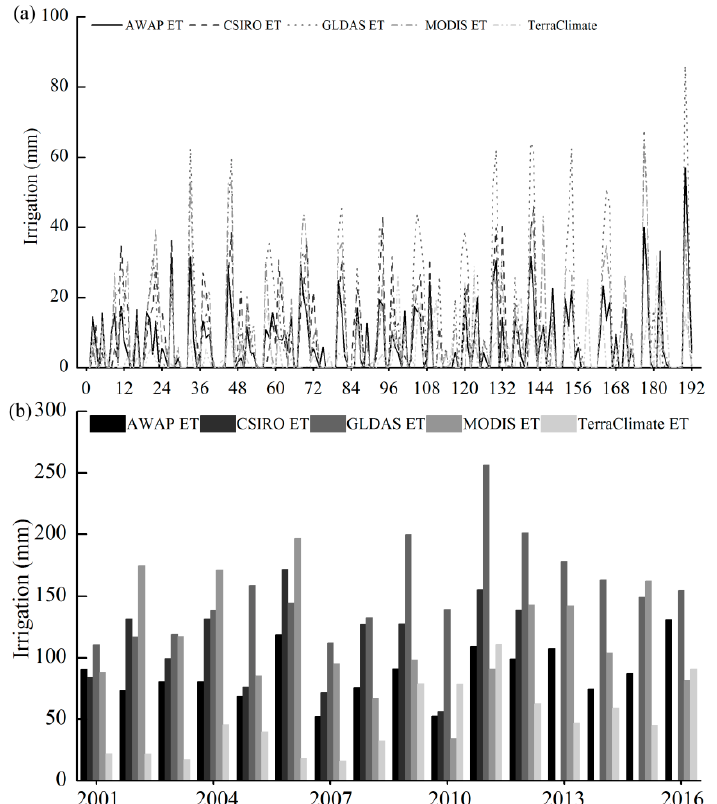
Figure 7. The monthly ( a ) and annual ( b ) irrigation water estimated using different ET